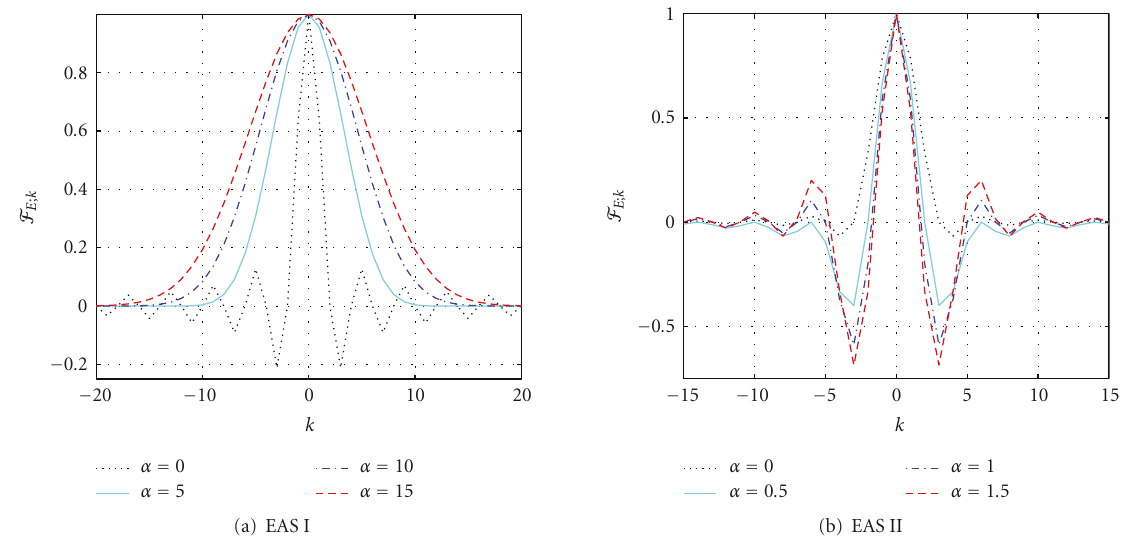
Figure 2: Fourier series coe ffi cients of di ff erent suggested elevation pdfs (EASs) , in two di ff erent propagation environments: (a) EAS I and (b) EAS II. Di ff erent environments are specified by di ff erent values of the degree of urbanization α .